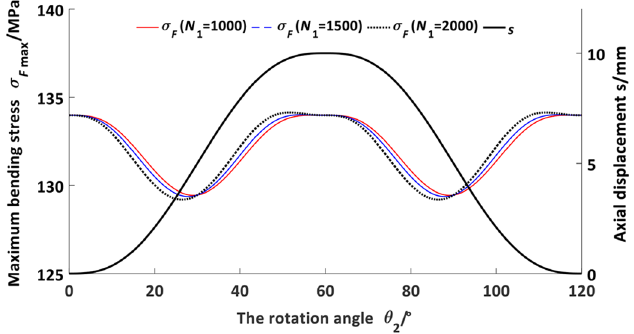
Fig. 14. In fl uence of N 1 on s F and s .